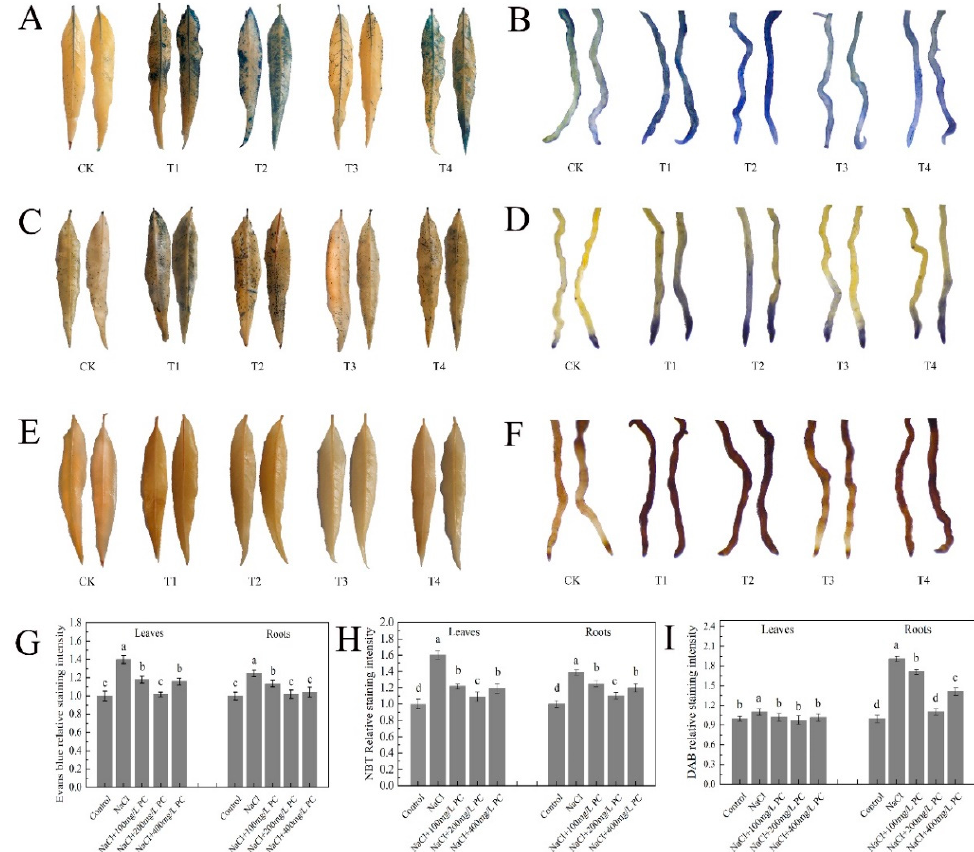
Figure 6. Leaves and roots staining. ( A ) Evans blue-staining of leaves; ( B ) Evans blue-staining of roots; ( C ) NBT staining of leaves; ( D ) NBT staining of roots; ( E ) DAB staining of leaves; ( F ) DAB staining of roots; ( G ) Relative Evans blue-staining intensity; ( H ) Relative NBT staining intensity; ( I ) DAB relative staining intensity. Control treatment (CK, a negative control group); tree treatment with only 70 mmol/L NaCl (T1); tree treatment with 70 mmol/L NaCl and 100 mg/L PC (T2); tree treatment with 70 mmol/L NaCl and 200 mg/L PC (T3); tree treatment with 70 mmol/L NaCl and 400 mg/L PC (T4). The data were sampled at 8:00 am on the 12th day after the salt stress treatment. Measurements were performed using the root tips of peach plants. Error bar represents standard deviation of the mean ( n = 3). Different lowercase letters indicate significant differences among different treatments (Duncan test, p < 0.05).